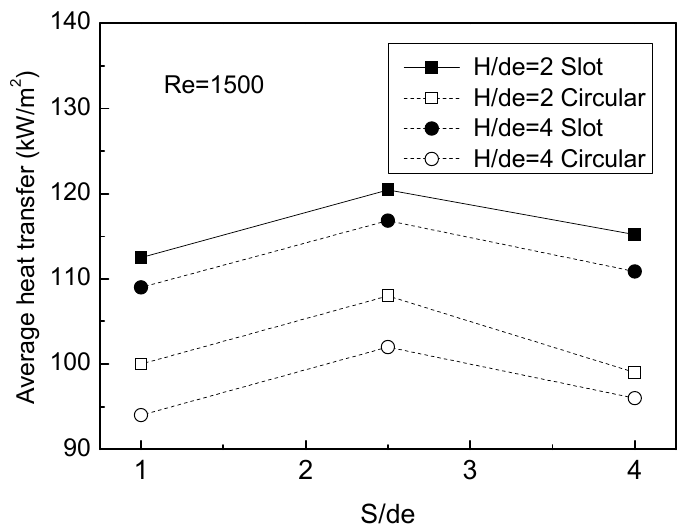
Figure 9. Comparison of area-averaged heat flux of slot and round LPG flame array at Re = 1500. For the single jet, according to the studies of Kwok et al. [6], the circular jet has a higher peak flux located at the impinging region compared with that of the slot jet. The rapid decrease in the heat flux of the circular jet contributes the small contact area for impingement heat transfer. By contrast, the slot jet can provide the more uniform heat flux distributions in the horizontal plate in both the x and y directions. This gives rise to the heat flux of the slot flame jet having a much more moderately decreasing slope than that of the circular flame jet, which results in a larger surface area with higher average heat flux. Hence, the area-averaged heat transfer of the slot jet is much higher than that of the circular jet. For the multiple jets, besides the above reason, it is proposed that the effect of jet-to-jet spacing can be more significant on the circular flame jets than the slot jets. Com- pared with the slot flame jets, a greater discrepancy of average heat flux between the cen- tral and side jets can be observed in the case of the circular jets [1]. Overall, it is known that the multiple slot flame jets can be suggested to be more capable of generating higher and more uniform heat flux along the impingement plate. 3.4.2. Comparison of the Emission Characteristics Figure 10a,b show the comparison of the EICO and EINO x for the slot and circular jets. There are similar EICO variations for the slot and circular jets. Specifically, the EICO decreases with the jet-to-plate distance, and the maximum EICO occurs at the jet-to-plate distance of 1. However, compared with the slot jets, the value of EICO is about 30–50% lower than that of the circular jets. At the same Reynolds number, the mass of the fuel/air mixture supplied in the slot and circular flame jets is the same. In the slot pattern setting, since the jet interaction occurs between the length sides of the center and side jets, the air entrainment in the jet interaction zone can be suppressed considerably. This contributes to the much higher CO emission of the slot jet pattern than that of the circular jet pattern, as shown in Figure 10a. As shown in Figure 10b, at the jet-to-jet spacing of 1, the EINO x values for both slot jets and circular jets are quite low with the EINO x being slightly higher for the circular jets. At the other two jet-to-jet spacings, compared with slot jets, the EINO x increases evi- dently by 58–76% for the circular jets. In addition, it is noted that at larger jet-to-jet spac- ing, more oxygen is available in the combustion region and results in higher EINO x for both the slot jets and circular jets. The much higher EINOx of circular jets can result from the more effective air entrainment for the circular flame pattern, which provides more available oxidizer for the NOx production.